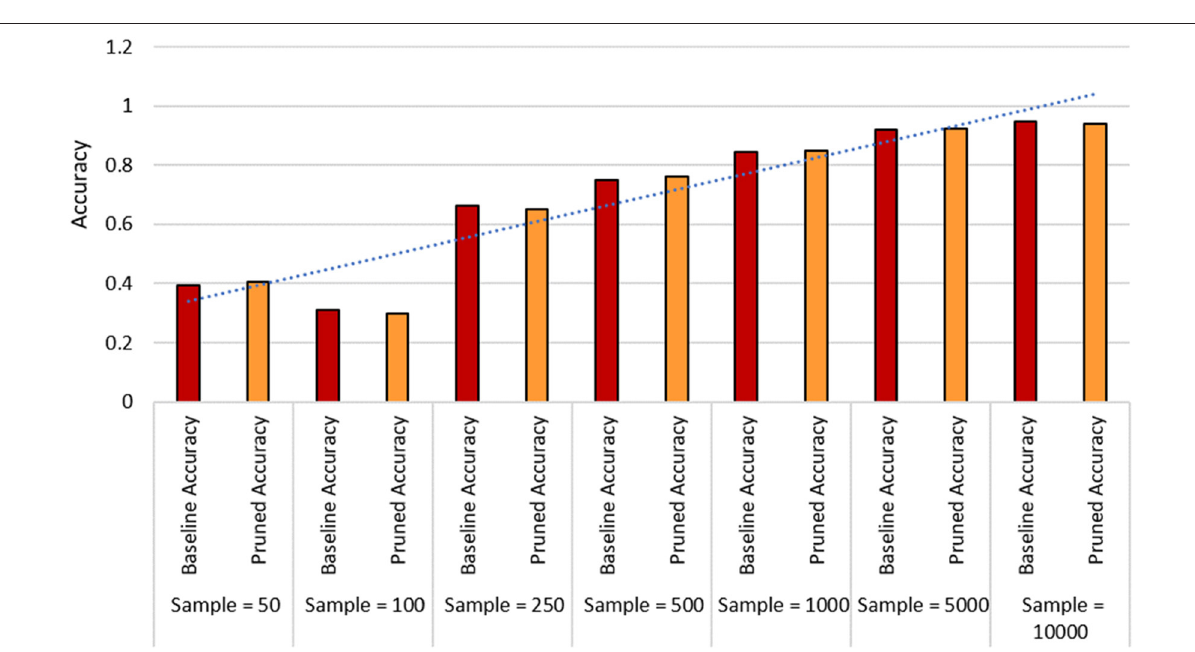
FIGURE 9 | Comparison between baseline accuracy and pruned model accuracy considering different sample